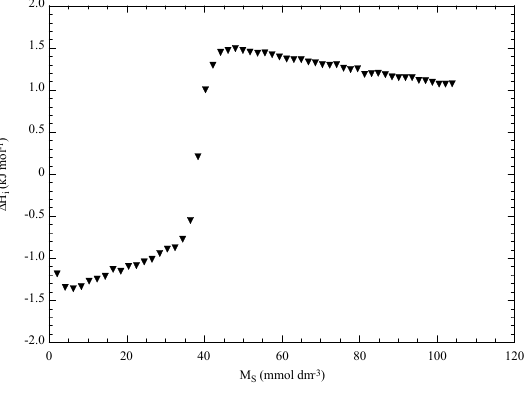
Figure 4. Enthalpy per moles of injected micellized surfactant (0.6 mmol dm -3 ) in water as a function of sodium decylsulfate molarity at 293 K. Data are from Ref.